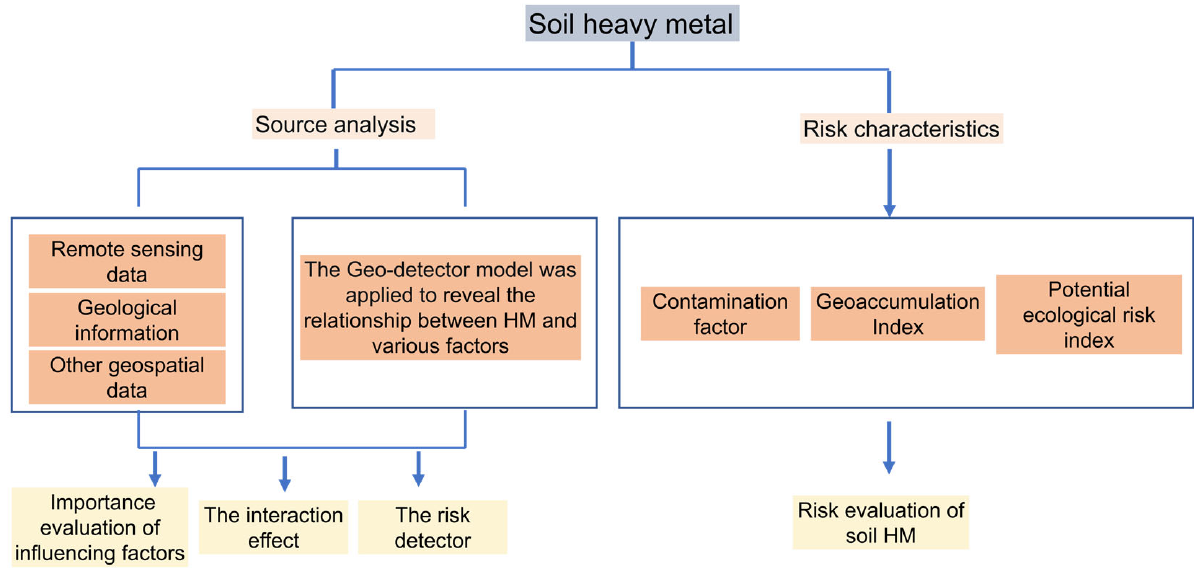
Figure 1. The f ramework of prediction methods for soil HM sources and risk characteristics. Figure 1. The framework of prediction methods for soil HM sources and risk